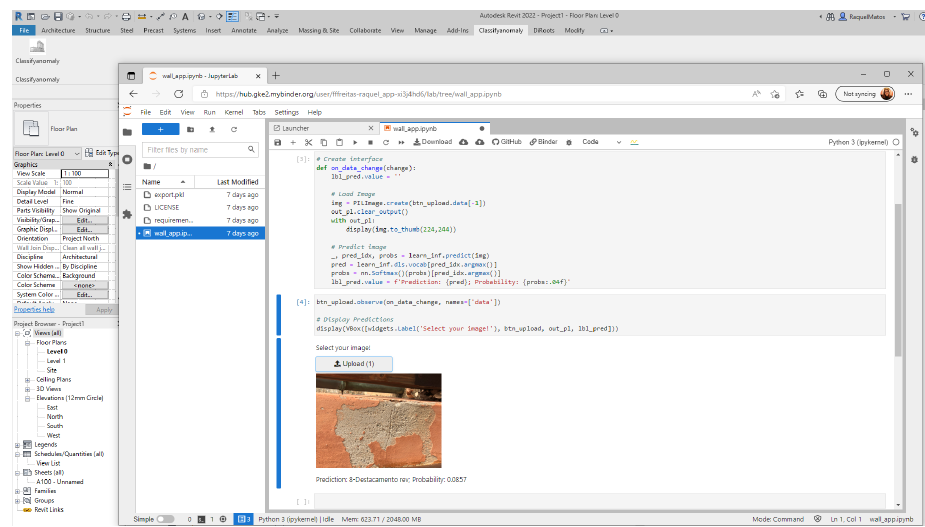
Figure 7. Example of anomaly classification by means of DL model: coverage detachment.